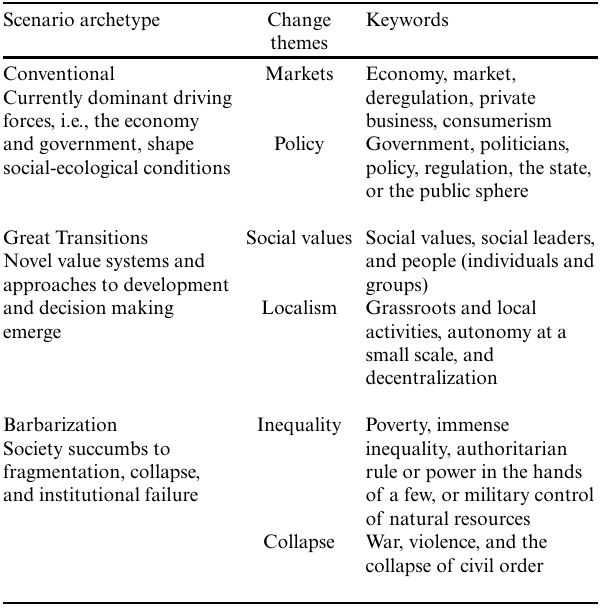
Table 1 . Scenario archetypes, change themes, and keyword descriptors. Adapted from Hunt et al. (2012).